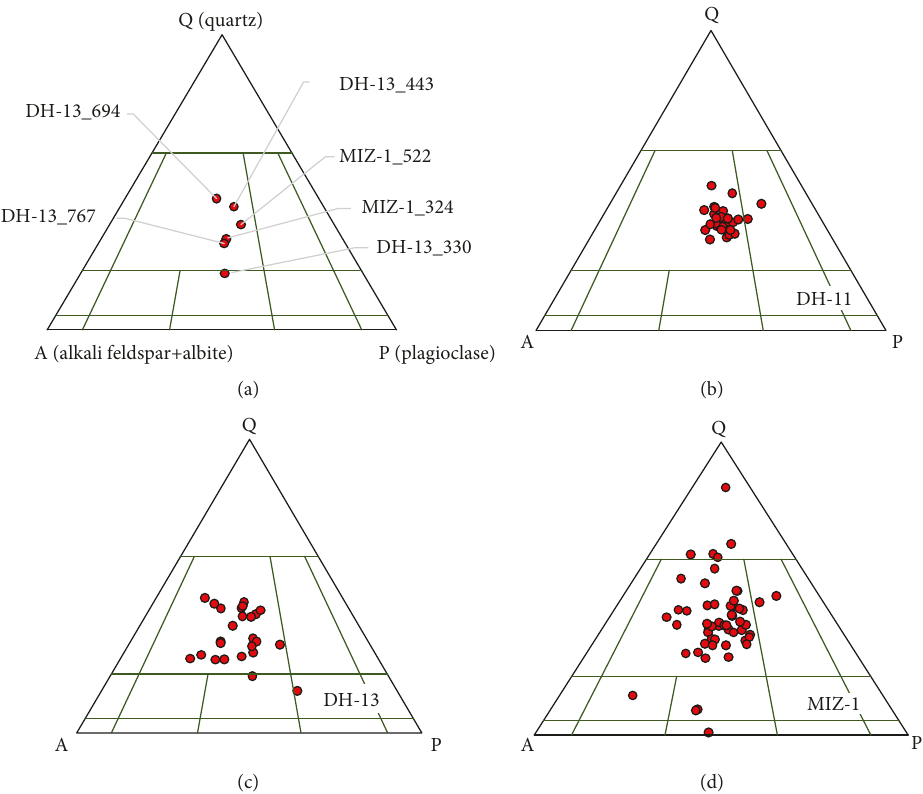
Figure 3: Mineral mode of rock core samples on the Q – A – P diagram (IUGS classi fi cation following [34]) based on the point-counting method of thin sections (more than 2000 counts each). (a) Mineral mode of the samples for EPMA. The borehole and depth in meters are indicated for the boreholes DH-13 and MIZ-1. (b – d) Mineral mode of other samples of DH-11, DH-13, and MIZ-1, respectively. Samples with a high H O content ( H O > 1 5 % ) are eliminated (c, 2 2